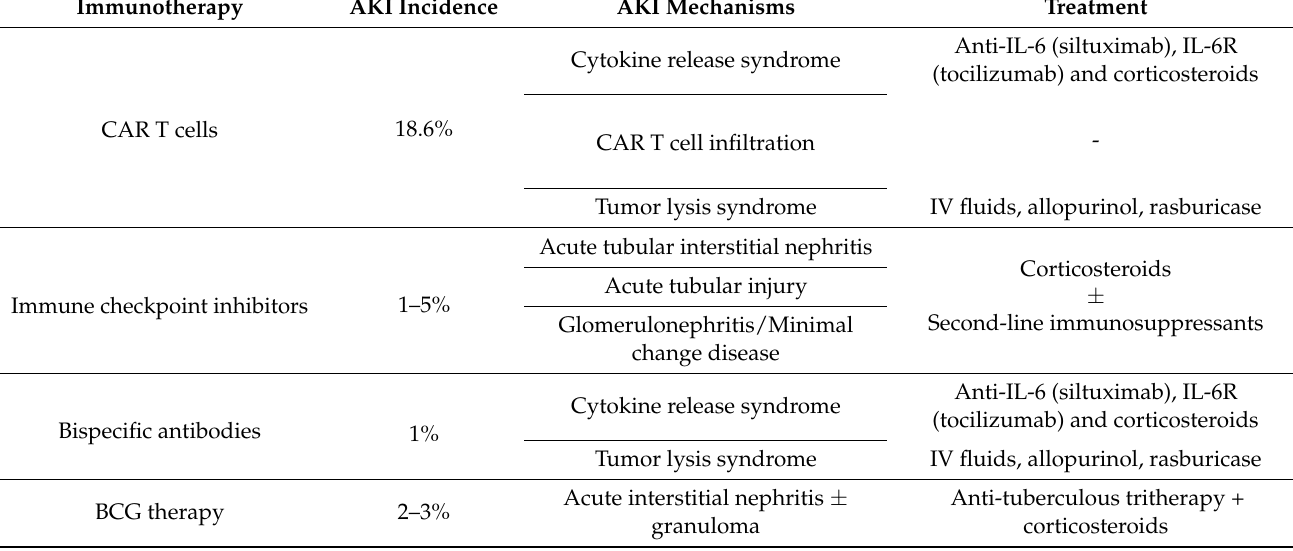
Table 2. Acute kidney injury associated with approved cancer